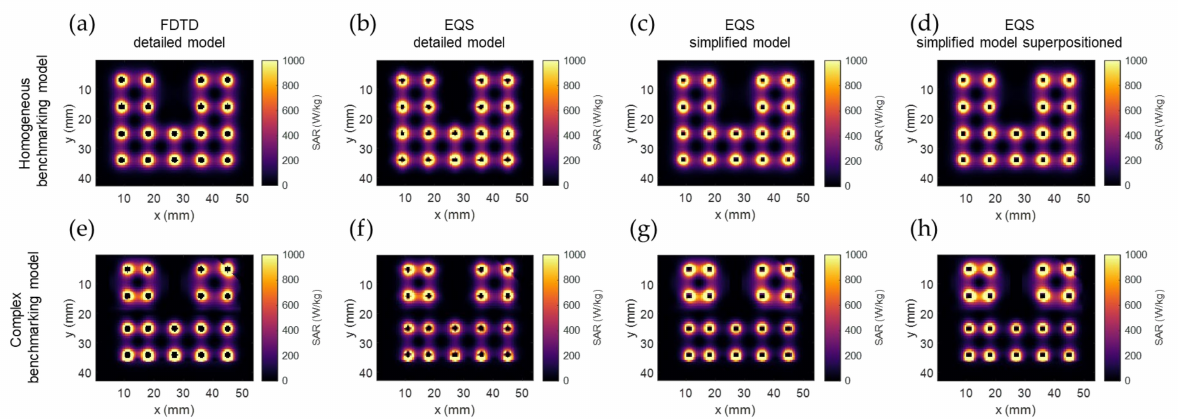
Figure 4. SAR calculation results of the different calculation methods in the two benchmarking models: ( a , e ) FDTD detailed model (calculation method 1); ( b , f ) EQS detailed model (calculation method 2); ( c , g ) EQS simplified model (calculation method 3); ( d , h ) superpositioned EQS simplified model (calculation method 4). The images show an axial slice passing through the center of the proximal electrode, as denoted with the green plane in Figure